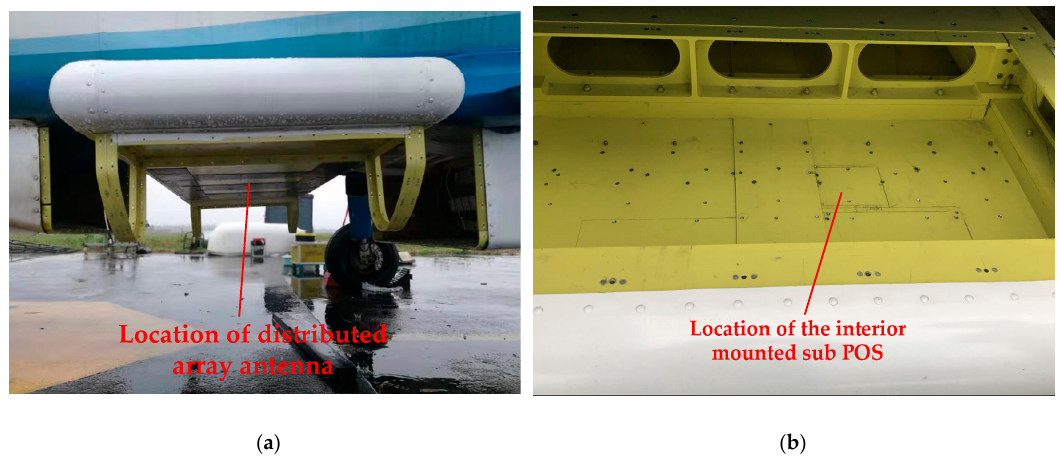
Figure 8. Physical layout of measurement scheme. ( a ) Location of distributed array antenna, ( b ) location of the interior mounted sub-POS.